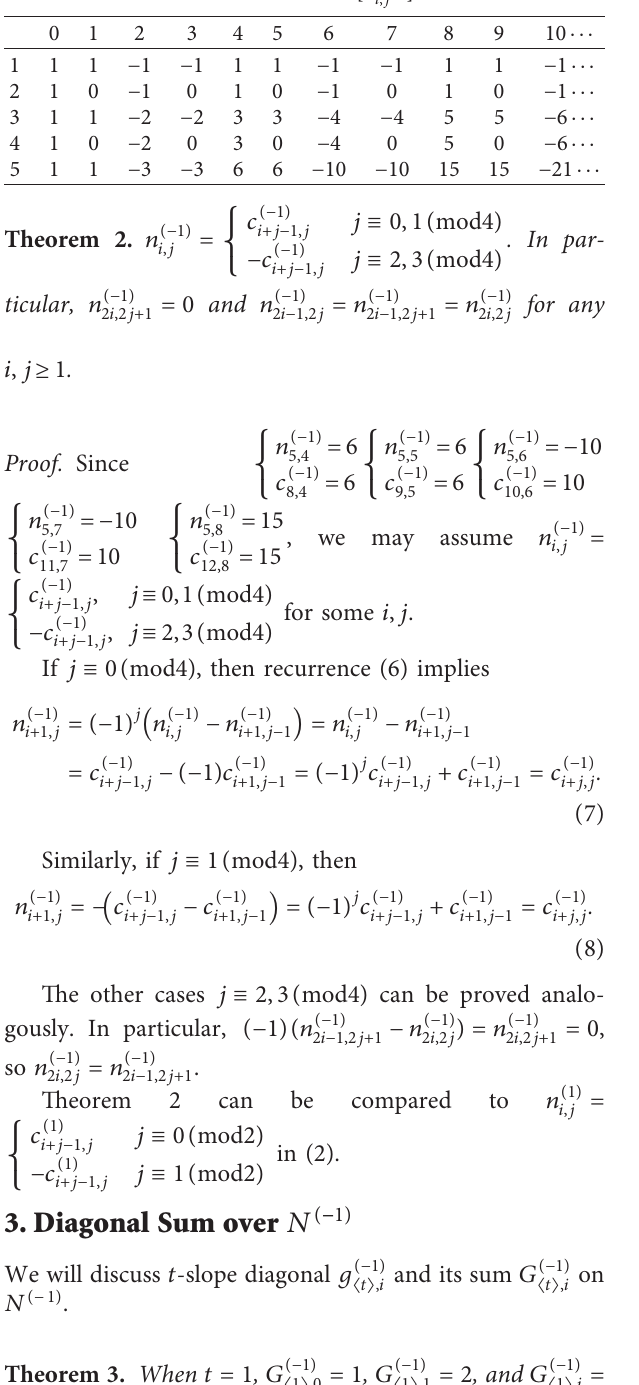
Table 3: N (− 1 ) � [ n (− 1 )